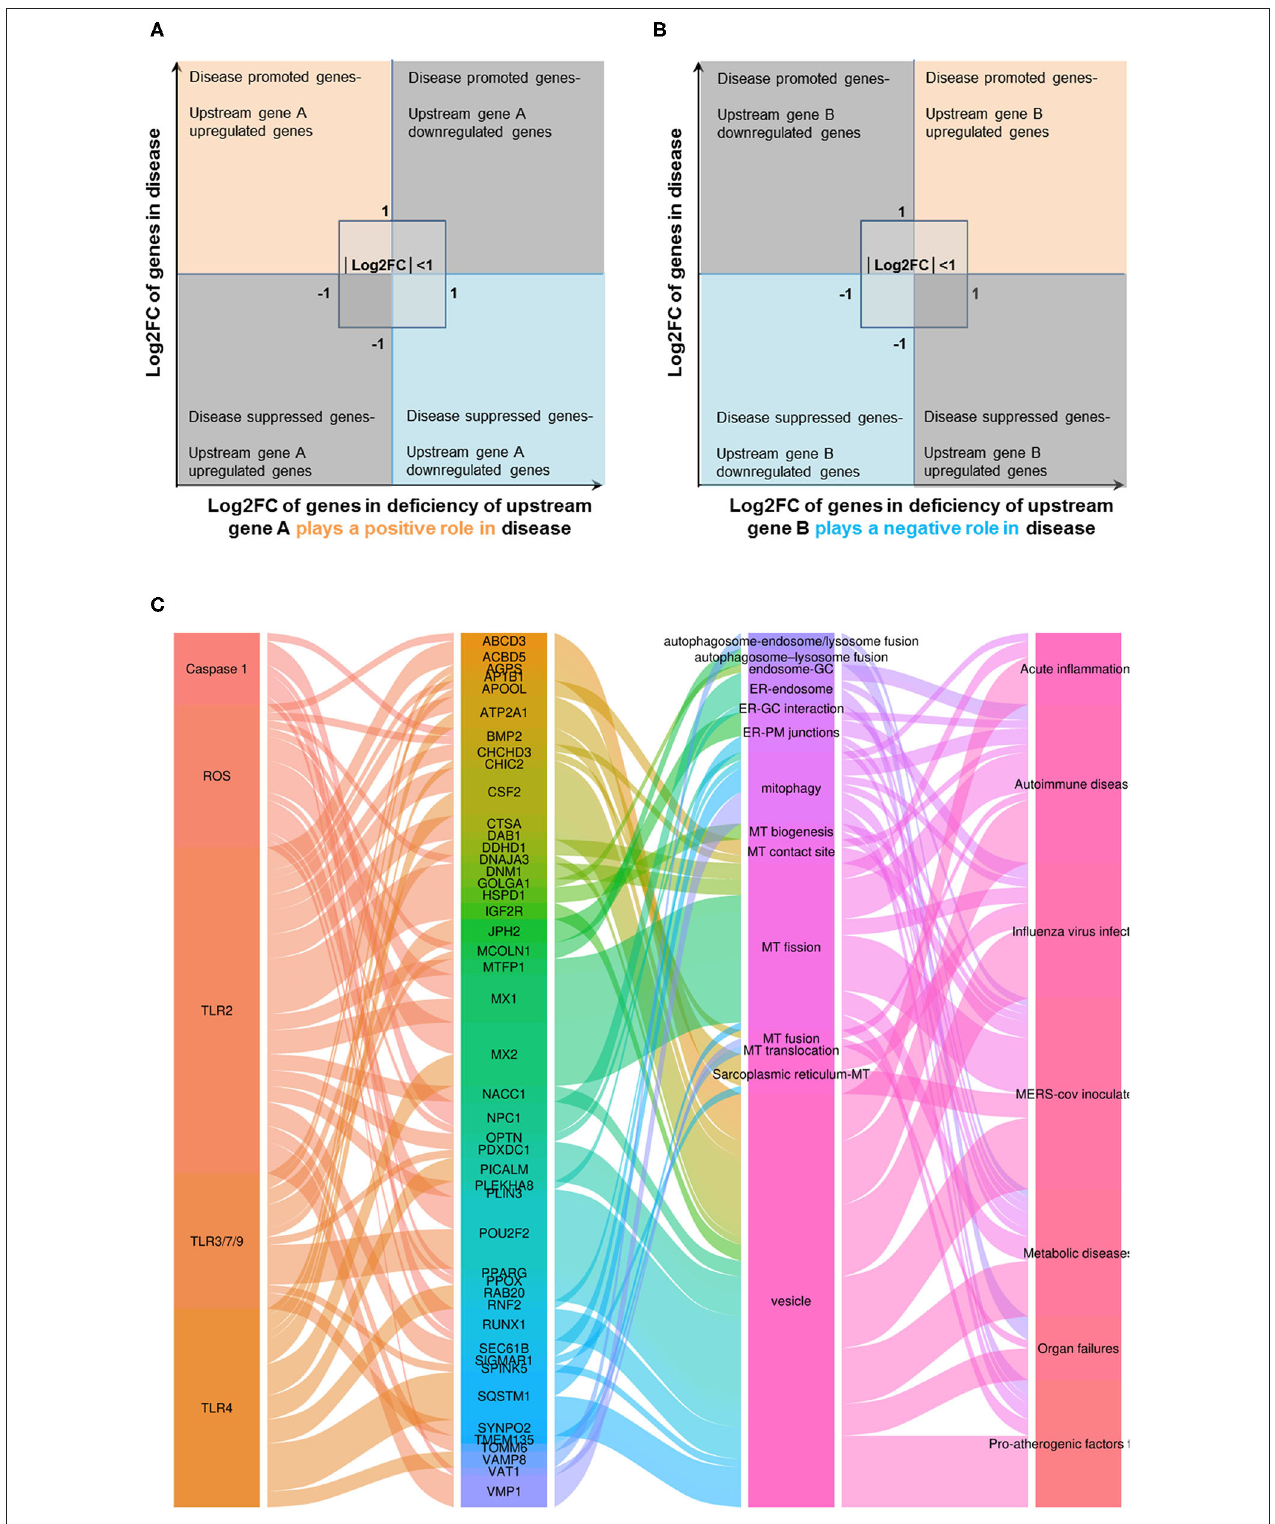
FIGURE 9 | Three types of regulators (TLRs, caspase-1, and ROS regulators) upregulated a total of 46 OCRGs in different diseases, and virus- and pro-atherogenic factor-treated cells. (A) Two models were used to explore the mechanisms of expression changes of OCRGs in the upstream gene-deficient microarrays. When